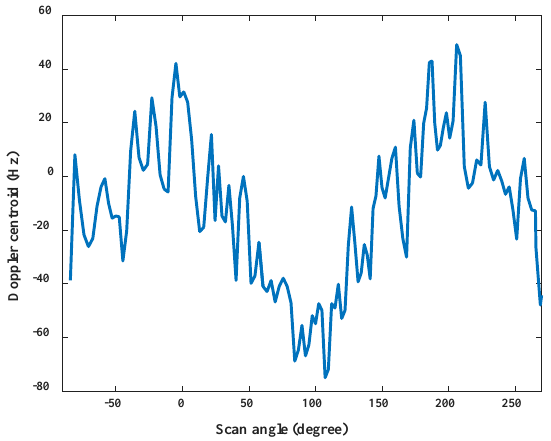
Figure 8. Estimated Doppler centroid shifts.